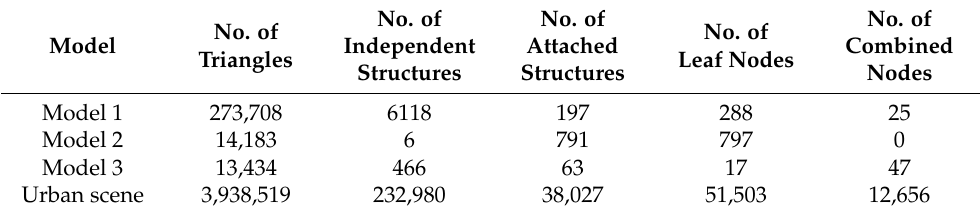
Table 1. Model information statistics.